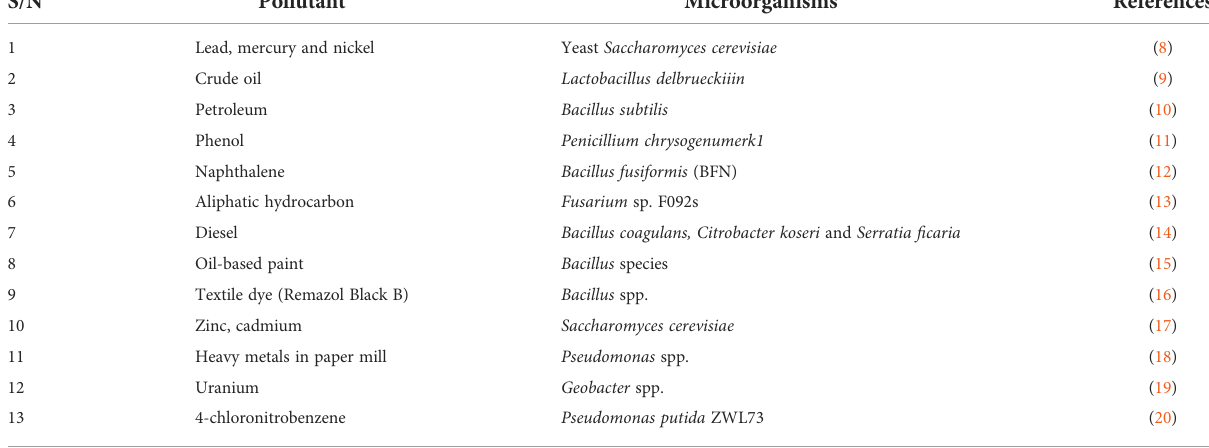
Table 1. Some common soil pollutants and microorganisms used in the process of remediation.